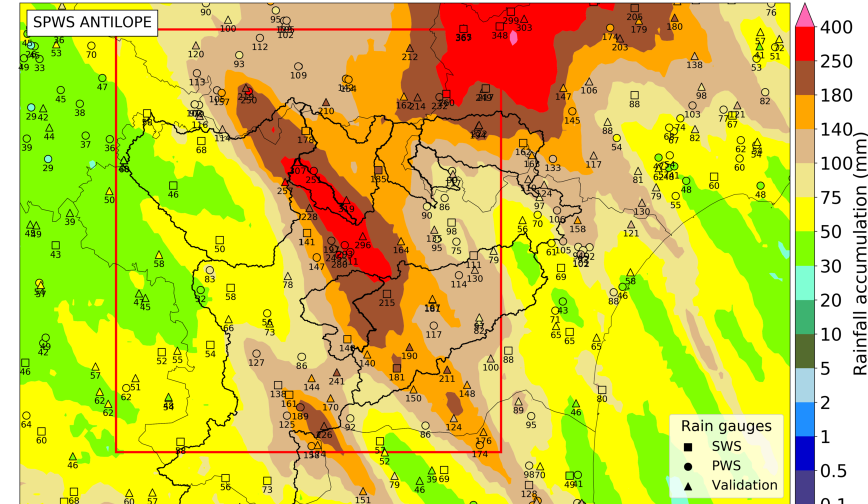
Figure 6. SPWS ANTILOPE 48h rainfall accumulation superimposed with rain gauge accumulations (mm) between 06:00UTC on 14 Oc- tober and 06:00UTC on 16 October. Major river basins are indicated in bold black. The red rectangle indicates the integration area used to rank the ensemble members (see Sect. 4.2).